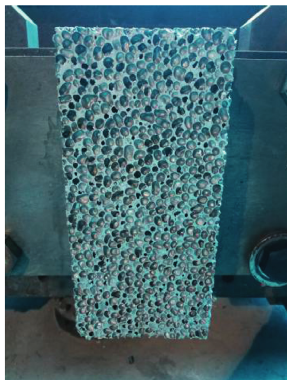
Figure 2: Closed-cell aluminum foam